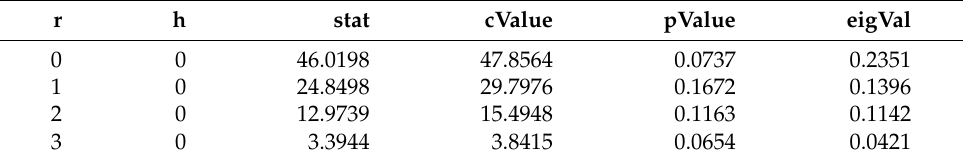
Table A3. Johansen Test.